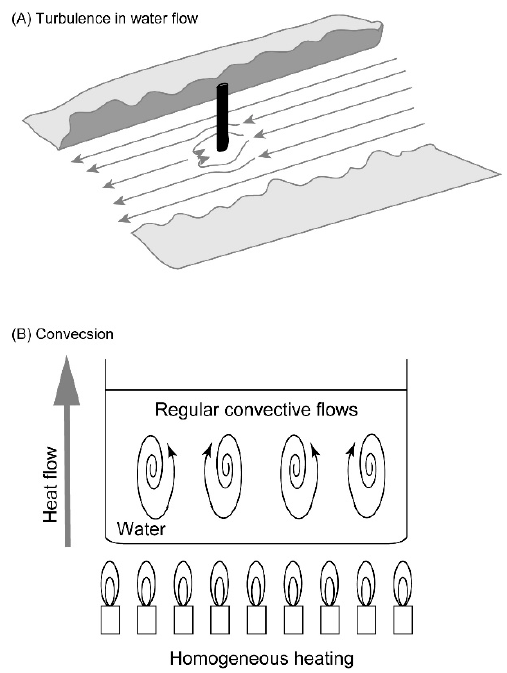
Figure 2. Turbulence and convection as examples of emergence. ( A ) Turbulence in water flow blocked by a stick pile. ( B ) Convection of water in a casserole heated evenly. These images are just schemes for explanation, but not based on observation.